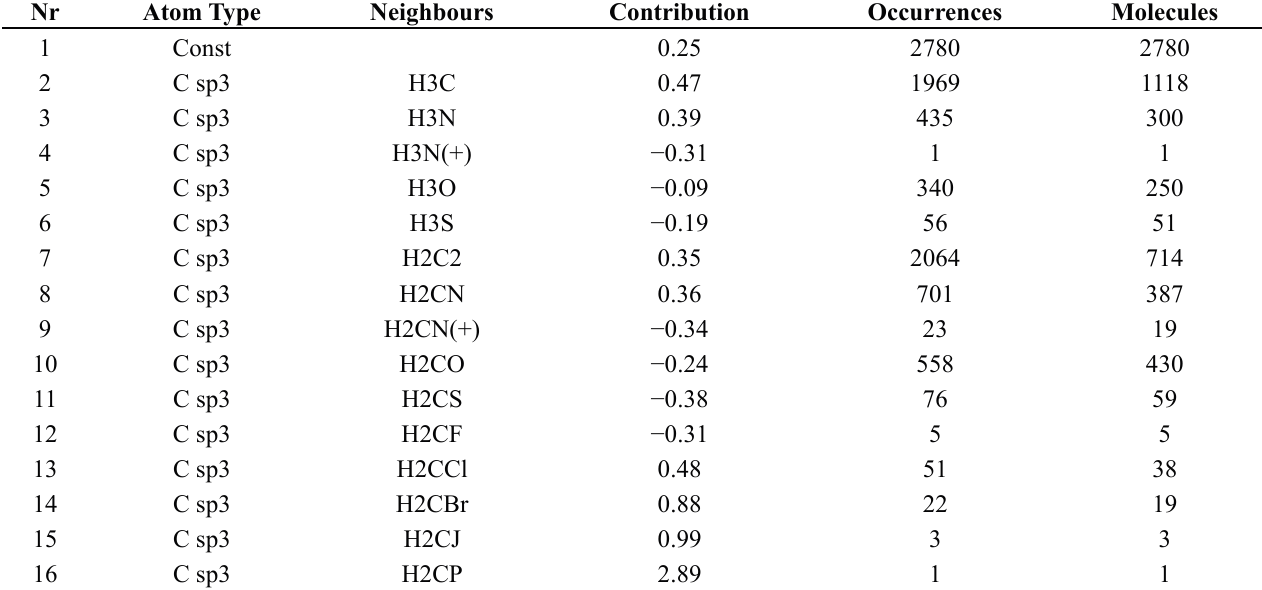
Table 8. Atom group Contributions for LogP